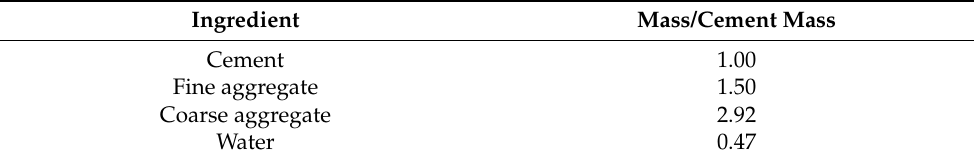
Table 1. Concrete mixture design.